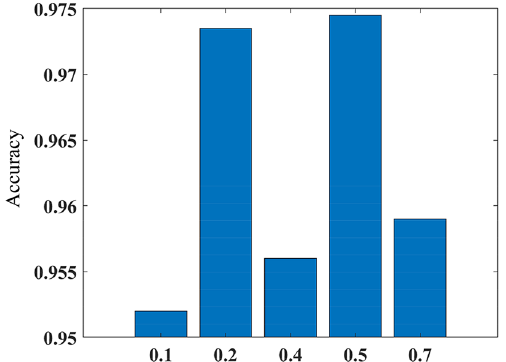
Figure 9. The accuracy of networks with different dropout parameters.